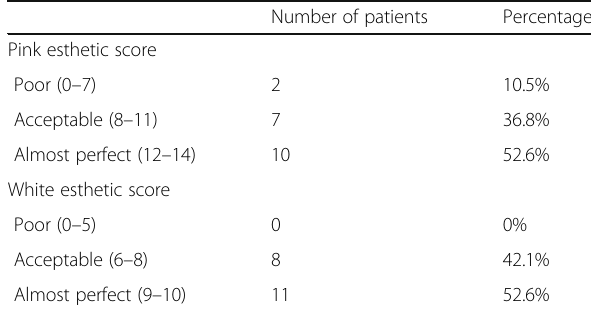
Table 2 Esthetic scores, sub-classification of the